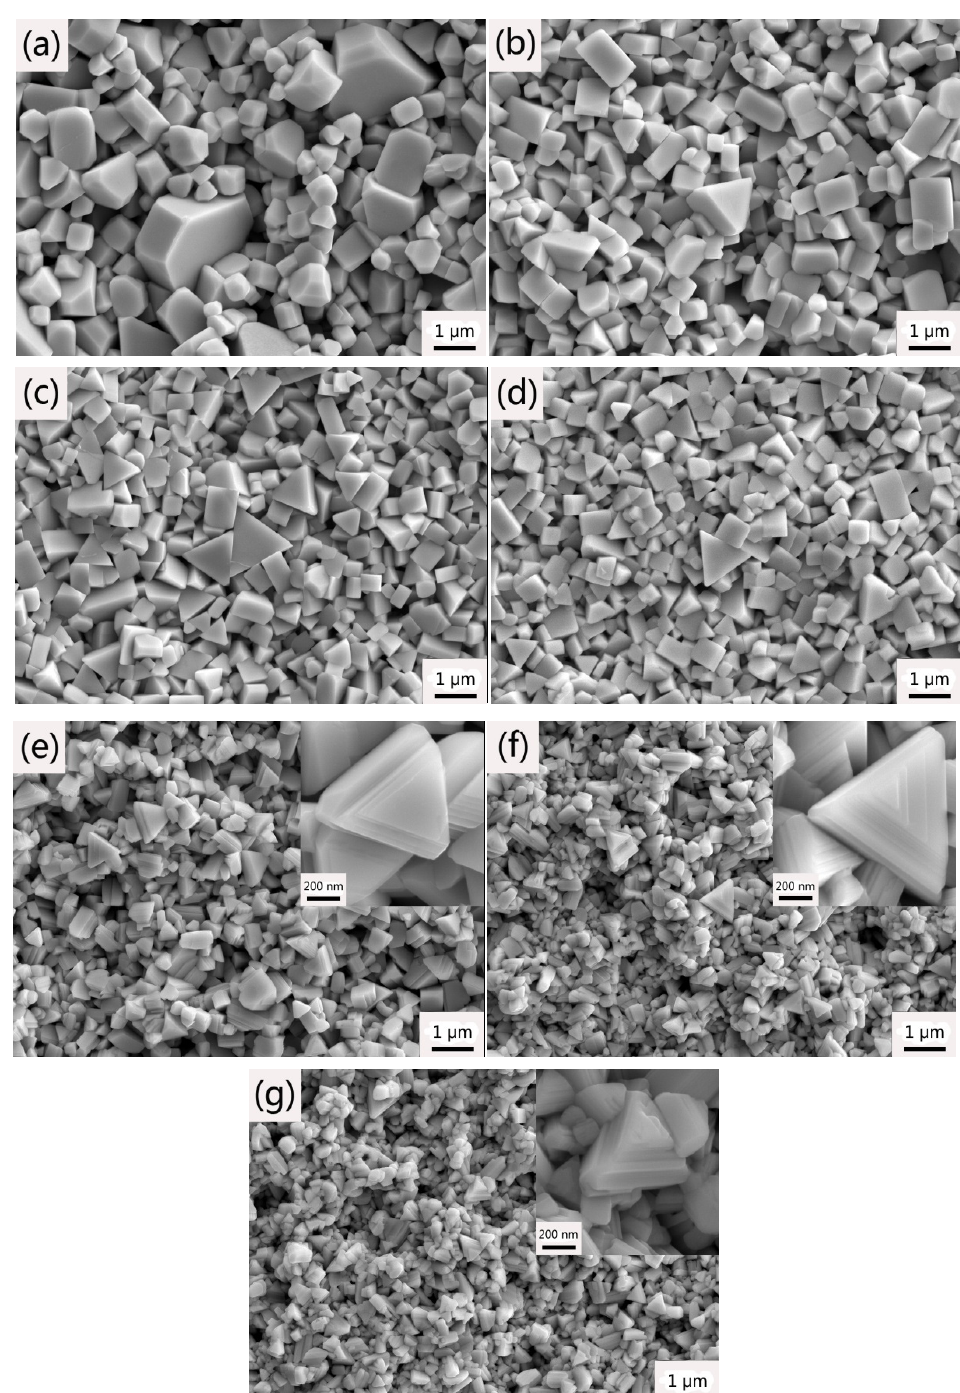
Figure 7. WC grain morphologies of WC–6Co–(Cr 2 C 3 /VC) cemented carbides sintered at 1450 °C.